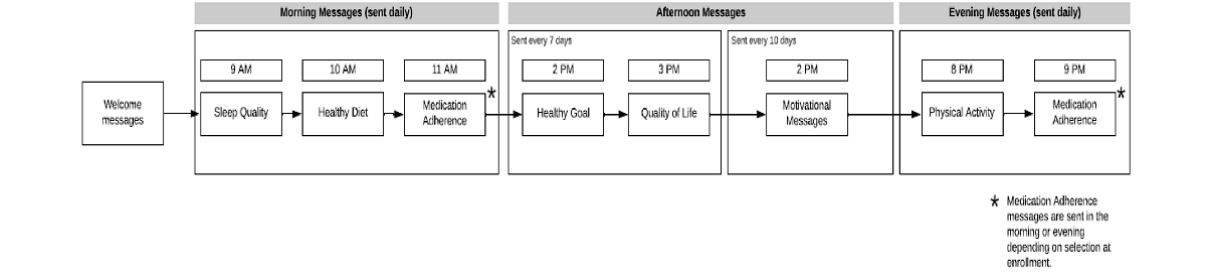
Figure 1. i-Matter study